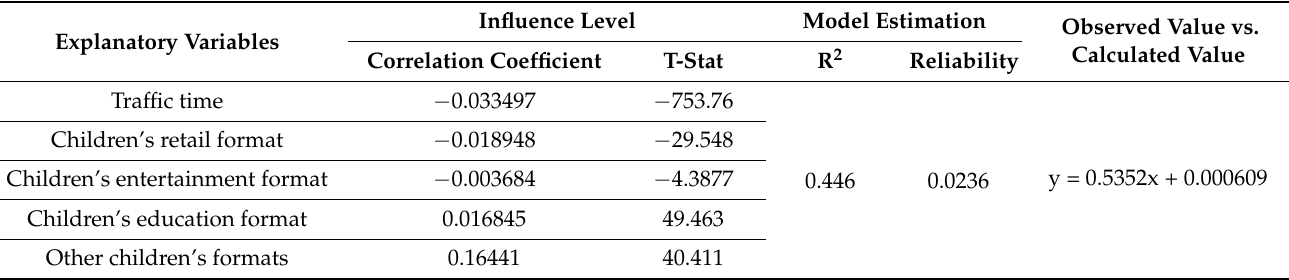
Table 4. Modeling results for commercial centers of county-level and community-level.